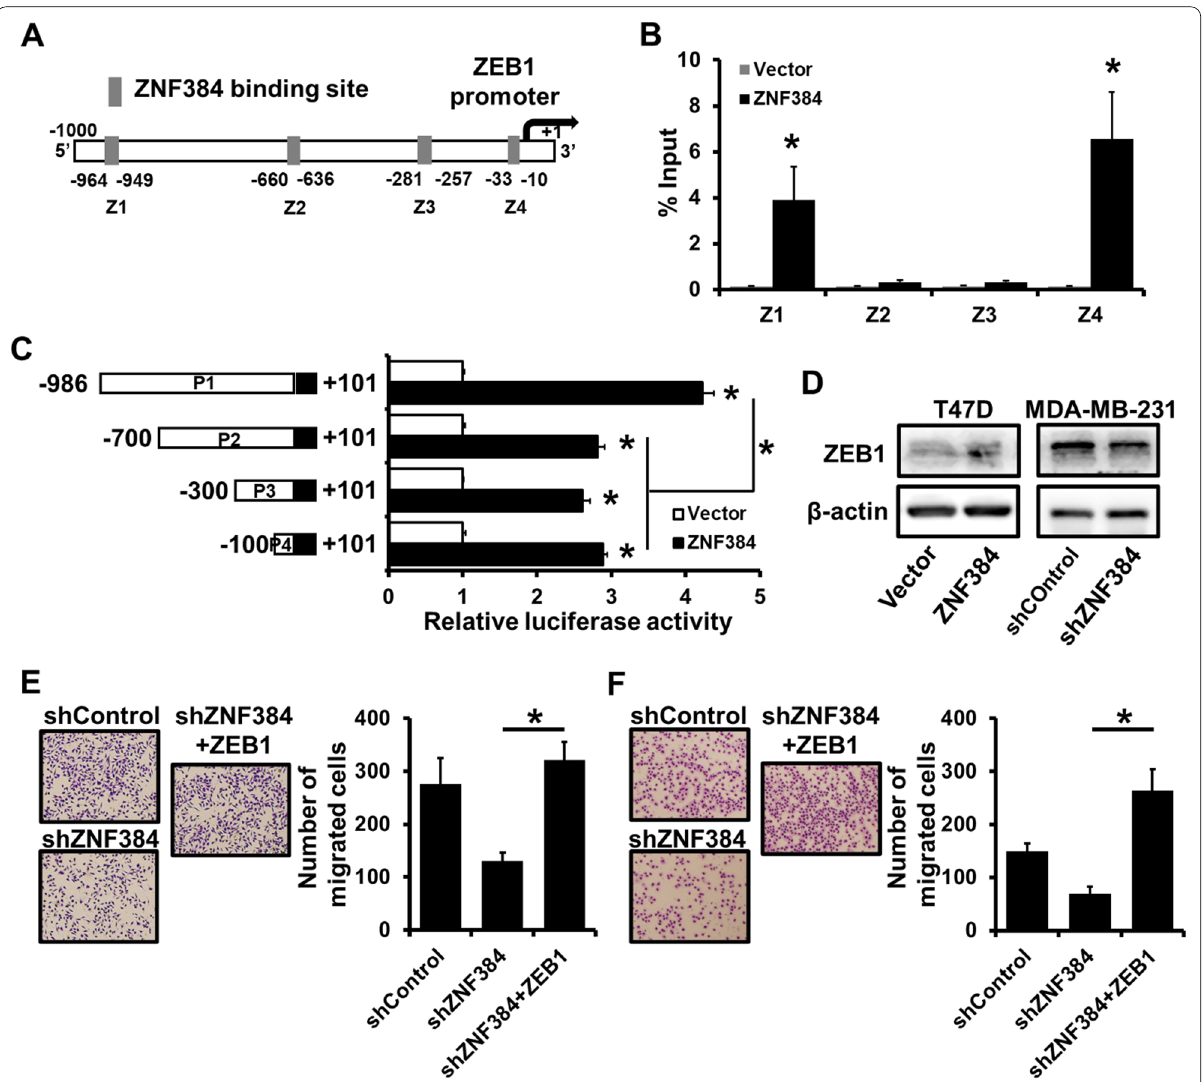
Fig. 5 ZNF384 promotes breast cancer progression by transactivation of ZEB1 expression. A Four potential ZNF384‑binding sites located in ZEB1 promoter region. B The interaction between ZNF384 and ZEB1 promoter region in 293FT cells verified by ChIP analysis. C The effect of ZNF384 expression on ZEB1 promoter activity determined by dual‑luciferase reporter analysis in 293FT cells. A series of fragments containing the predicted ZNF384 binding site is fused upstream of Luc gene. D ZEB1 expression determined by western blot in ZNF384‑overexpressed T47D cells or ZNF384‑depleted MDA‑MB‑231 cells, as well as control cells. E–F The ability of cell migration and invasion in ZNF384‑depleted MDA‑MB‑231 with or without ZEB1 overexpression determined by transwell analysis. * P <